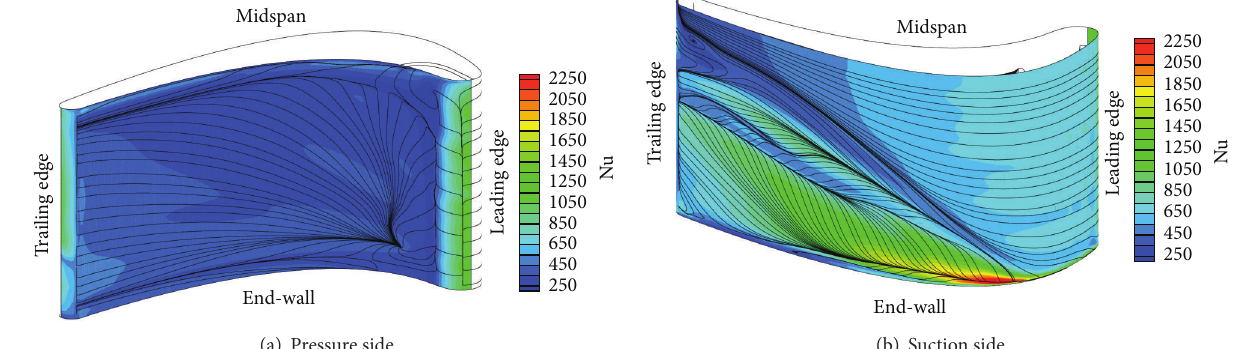
Figure 10: Surface Nusselt number, Re =